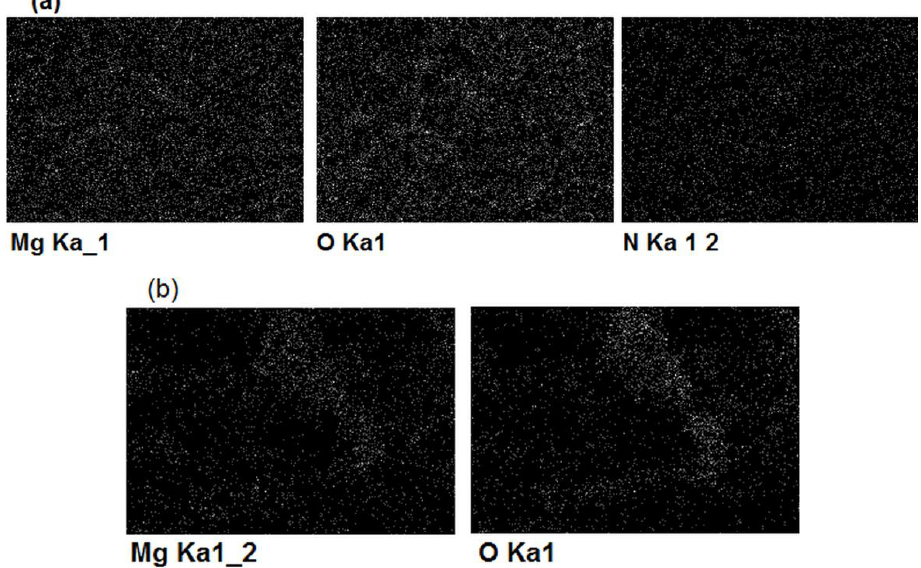
Figure 3. Characteristic EDS (energy dispersive spectrometry) spectra of gold samples after two hours time of magnesium underpotential deposition from: ( a ) magnesium/ammonium nitrate eutectic mixture melt at 400 K and ( b ) nonaqueous magnesium/ammonium nitrate eutectic mixture melt at 460 K.